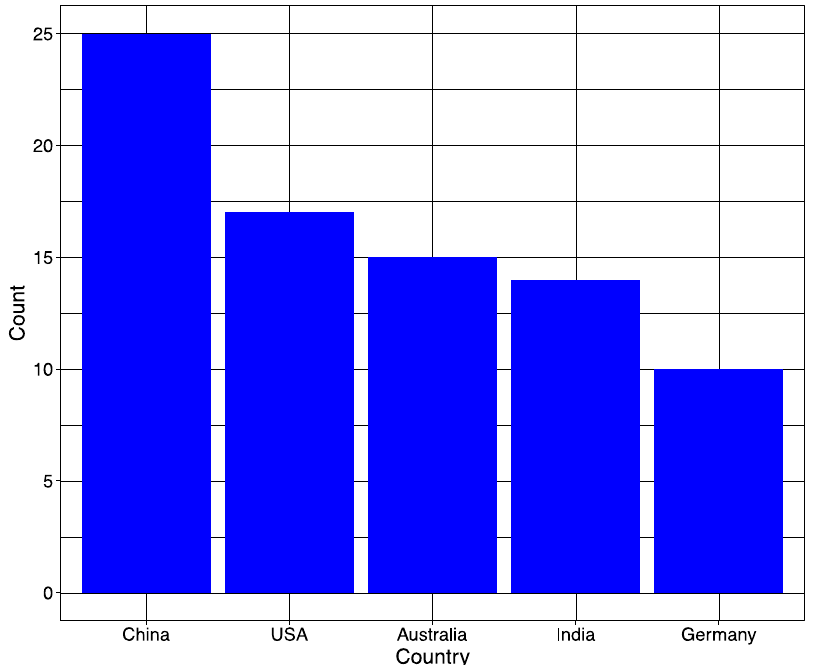
Figure 6. Most common countries examined in climate-related articles.